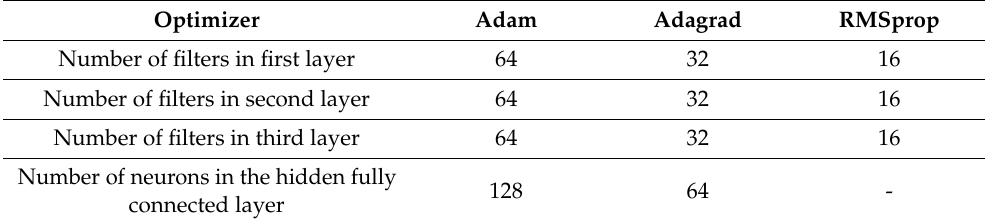
Table 1. Analyzed Table 1. Analyzed hyperparameters.